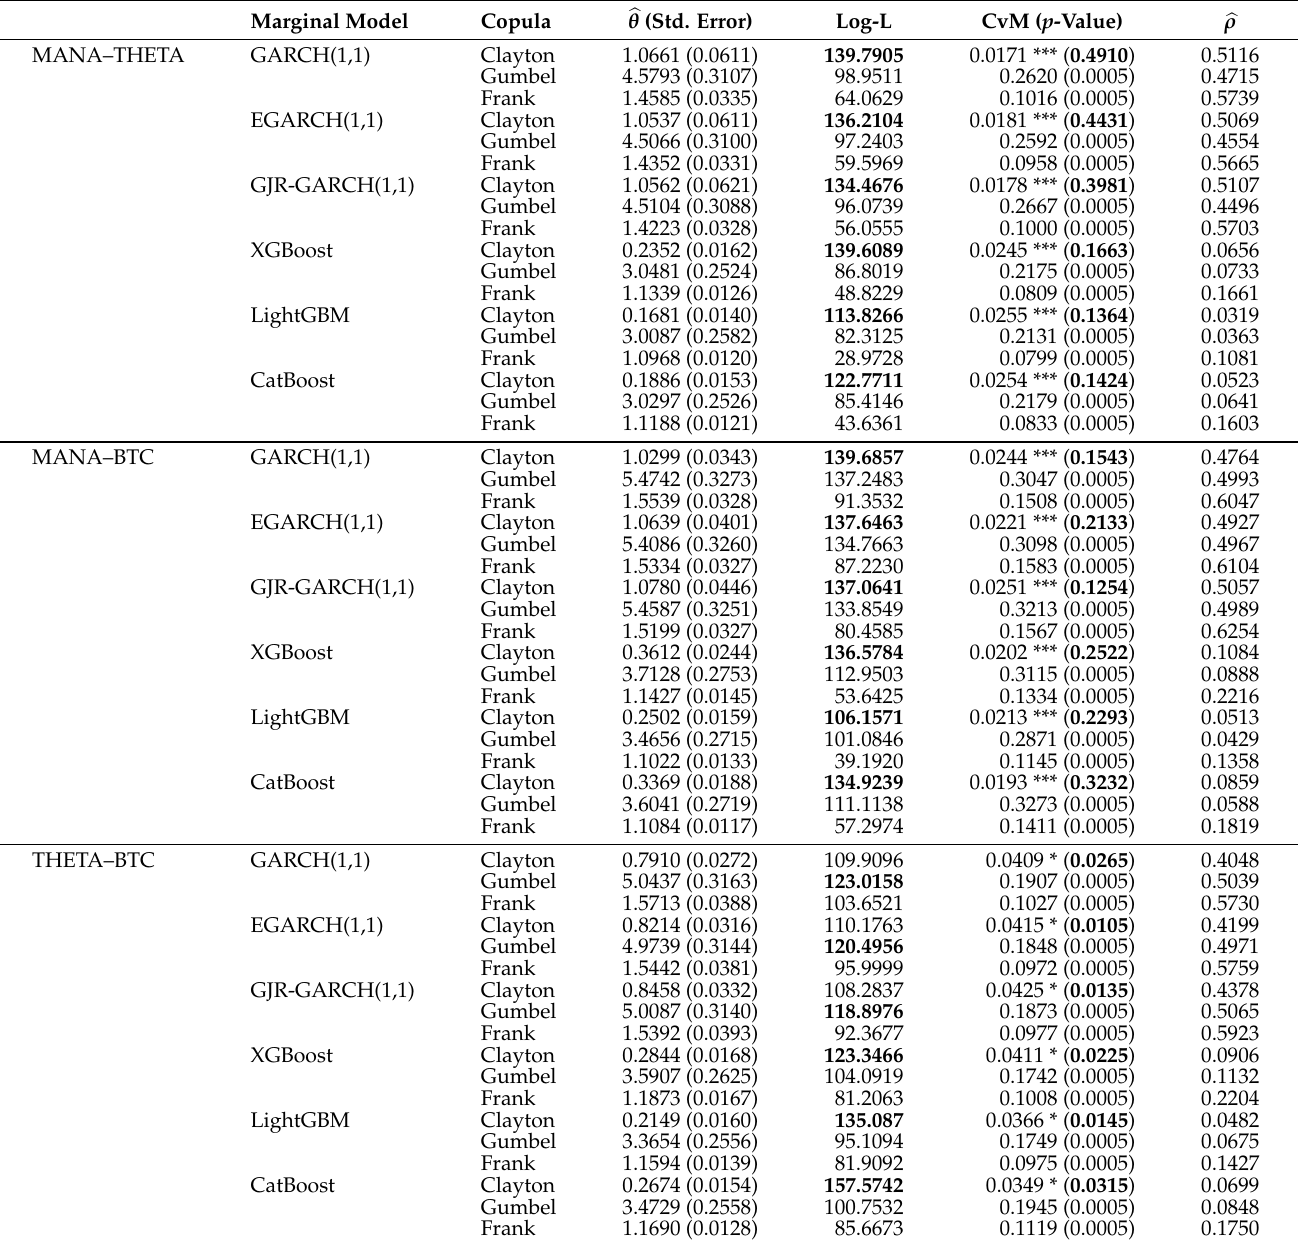
Table 7. Copula fitting and